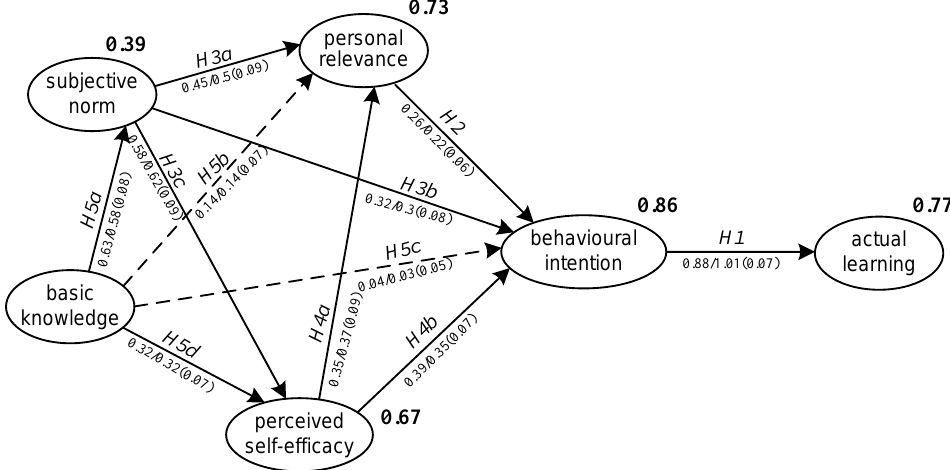
Figure 3. SEM results of the proposed structural model.